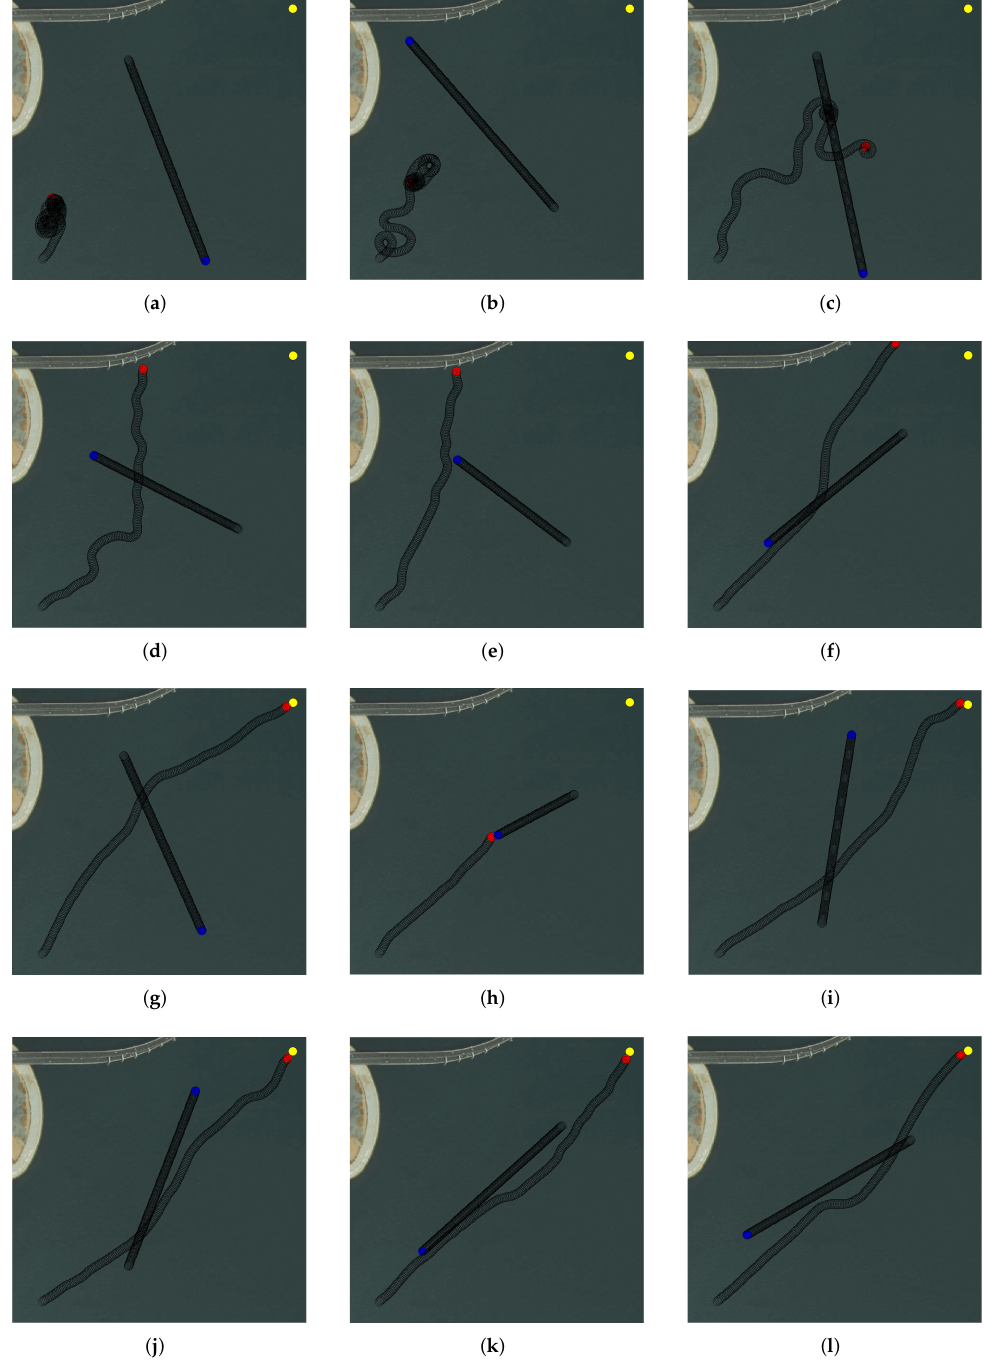
Figure 14. The training effect of different training stages: ( a ) 15 episodes; ( b ) 50 episodes; ( c ) 80 episodes; ( d ) 100 episodes; ( e ) 200 episodes; ( f ) 400 episodes; ( g ) 500 episodes; ( h ) 520 episodes; ( i ) 700 episodes; ( j ) 1000 episodes; ( k ) 1800 episodes; ( l ) 2000